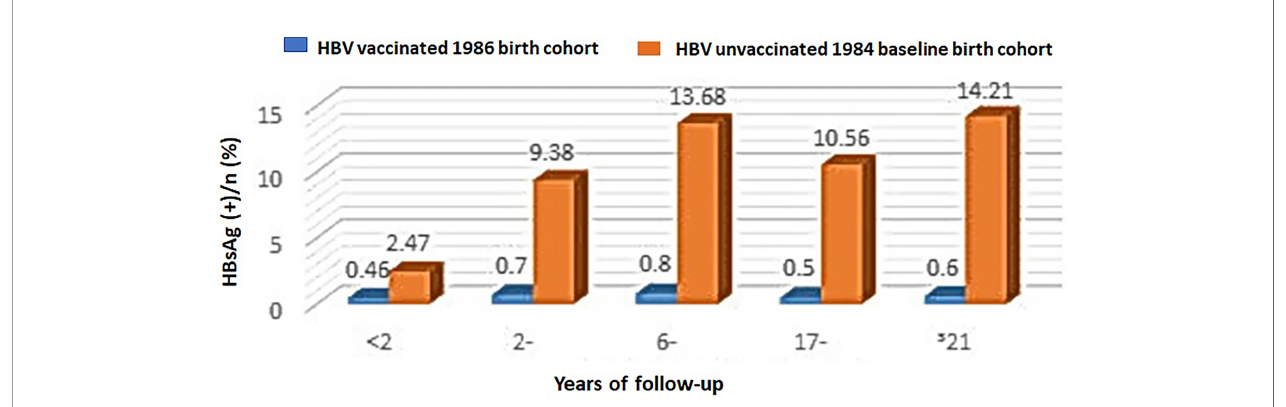
FIGURE 2 | HBsAg-positive rates in the HBV-vaccinated 1986 birth cohort at Huangpu district versus the unvaccinated 1984 birth cohort at Changning district in Shanghai